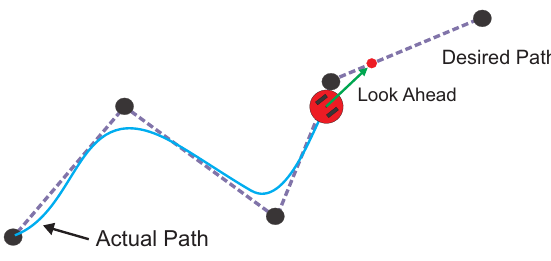
Figure 27. Pure-pursuit